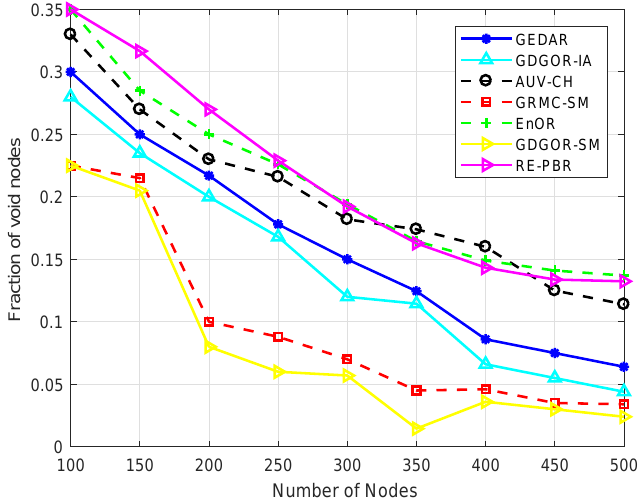
Figure 8. Fraction of void nodes plots.